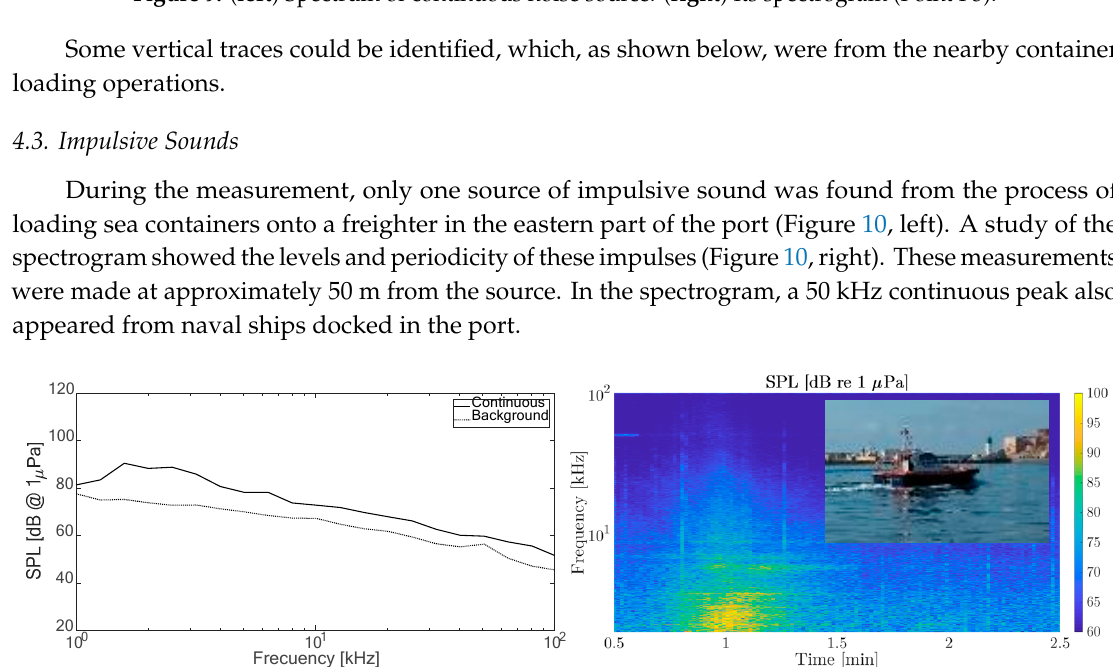
Figure 10. Loading a cargo ship ( left ), and spectrogram of the noise generated ( right ) at P2 in Figure 4. During the recordings, it was found that the appearance of the vertical lines in the spectrogram could be attributed to the container loading operations (especially banging noises). Some clear vertical lines can be seen in the spectrogram from this loading process. They had a considerable bandwidth (as they were pulses) with peaks of up to 85 dB at frequencies below 20 kHz. It was estimated that this impulsive source emitted around 100 dB re 1µPa re 1m. Although this source is currently not considered as a relevant sound source [14], it may be desirable to move forward with this analysis in a context of high intensity loading and unloading operations in different ports. The possibility of including this activity as a potential impulsive noise source could also be assessed, being taken into account in noise monitoring guidelines. 4.4. Propagation of Underwater Noise In these impulse noise source monitoring studies, we were interested in estimating the noise levels at various distances outside the port, as well as applying acoustic propagation models taking into account the characteristics of the water column and the soil.